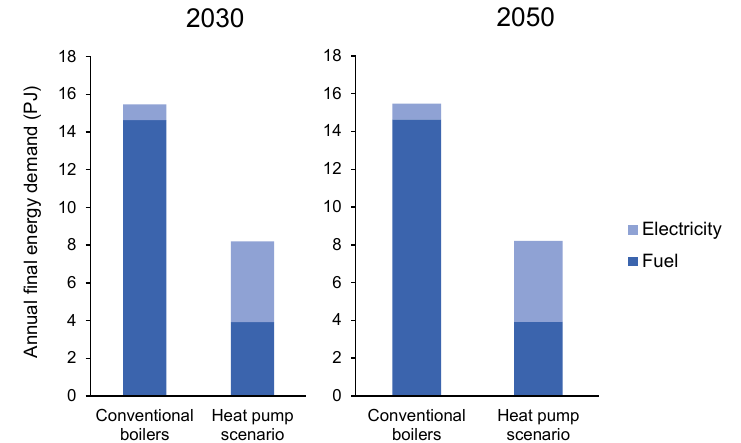
Figure 9. Annual final energy demand in the textile wet-processing industry in Taiwan .